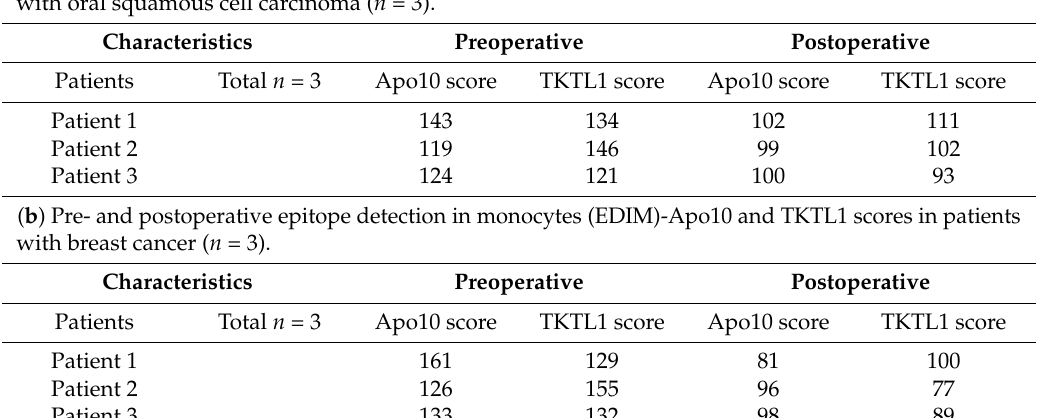
Table 2. Pre- and post-operative epitope detection in monocytes (EDIM)-Apo10 and TKTL1 scores in patients with ( a ) oral squamous cell carcinoma ( b ) breast cancer ( c ) prostate cancer. Table published in